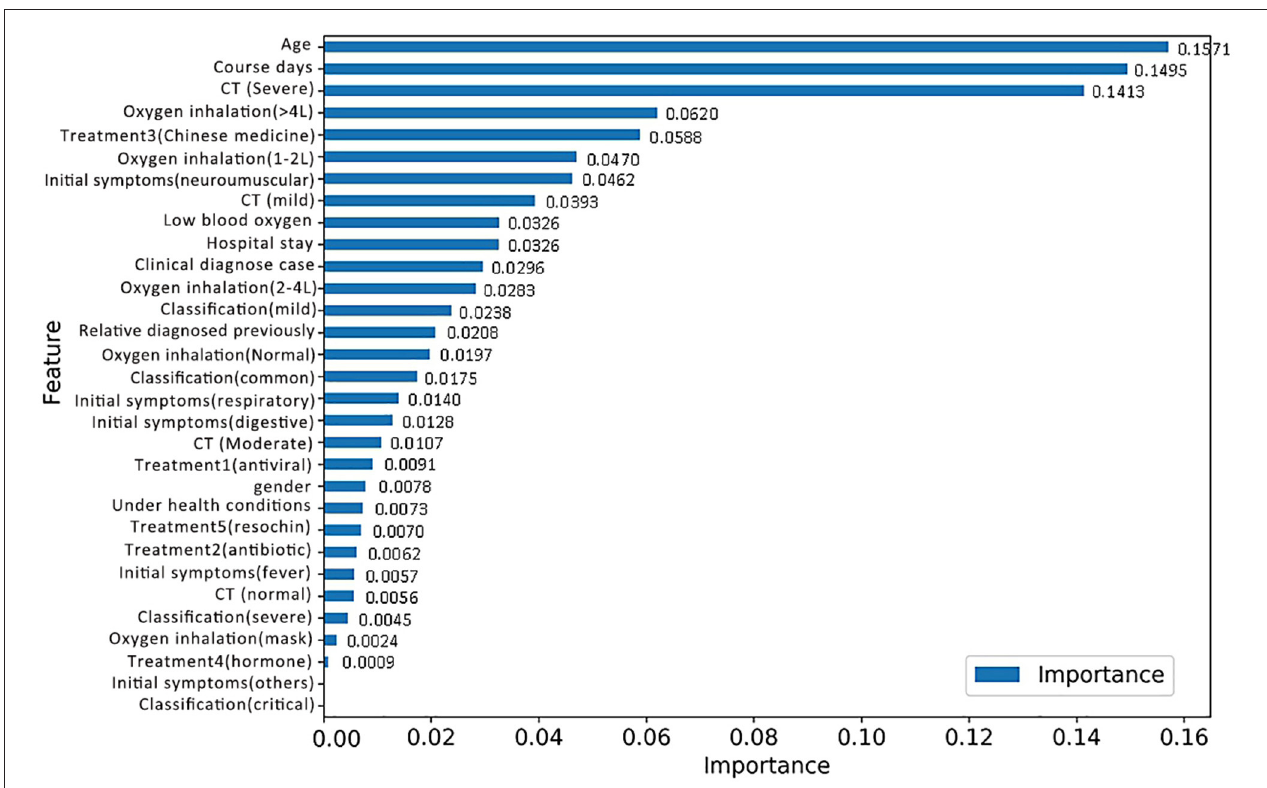
FIGURE 4 | Feature importance based on the RF model for discharged patients with positive RT-PCR test results and